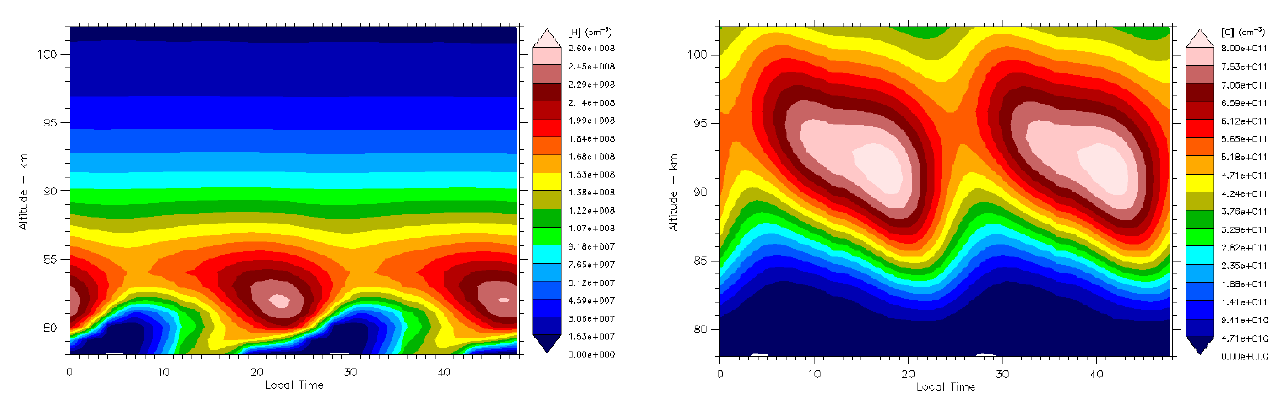
Fig. 2a. Simulated H for model days seven through eight for April at the Equator. The dominant determining factors are the H 2 O mixing ratio, from the ACE-FTS measurements, and the Lyman- α flux from the SORCE dataset.